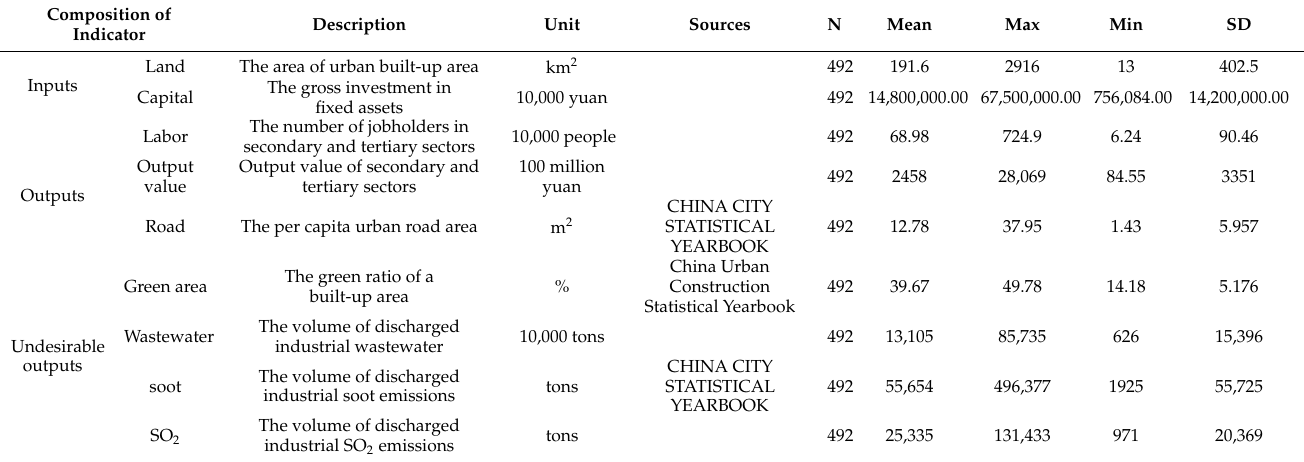
Table 1. Statistical description of Input-output